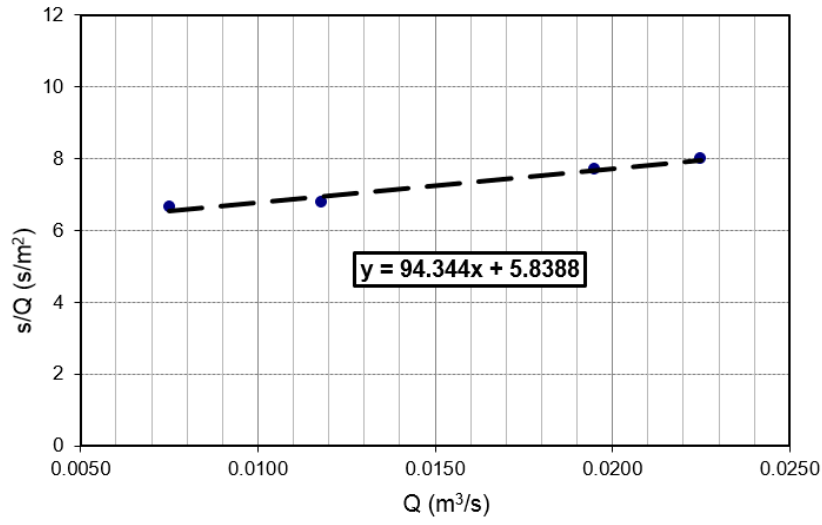
Figure 11. Values for B and C in the step test can be determined from a graph.